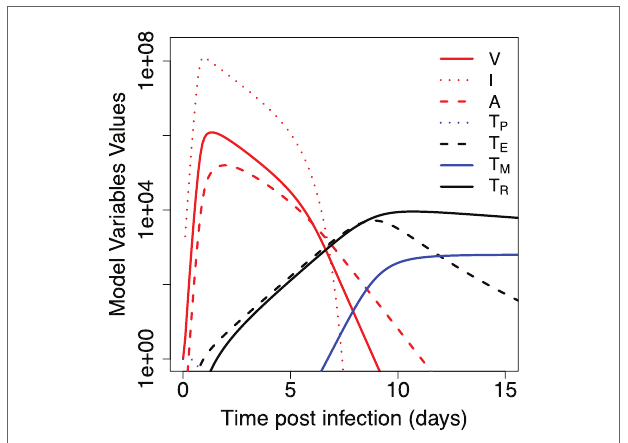
FIGURE 2 | Dynamics of primary immune response to influenza infection . Model parameters and initial values for model variables are shown in Tables 1 and 2 .